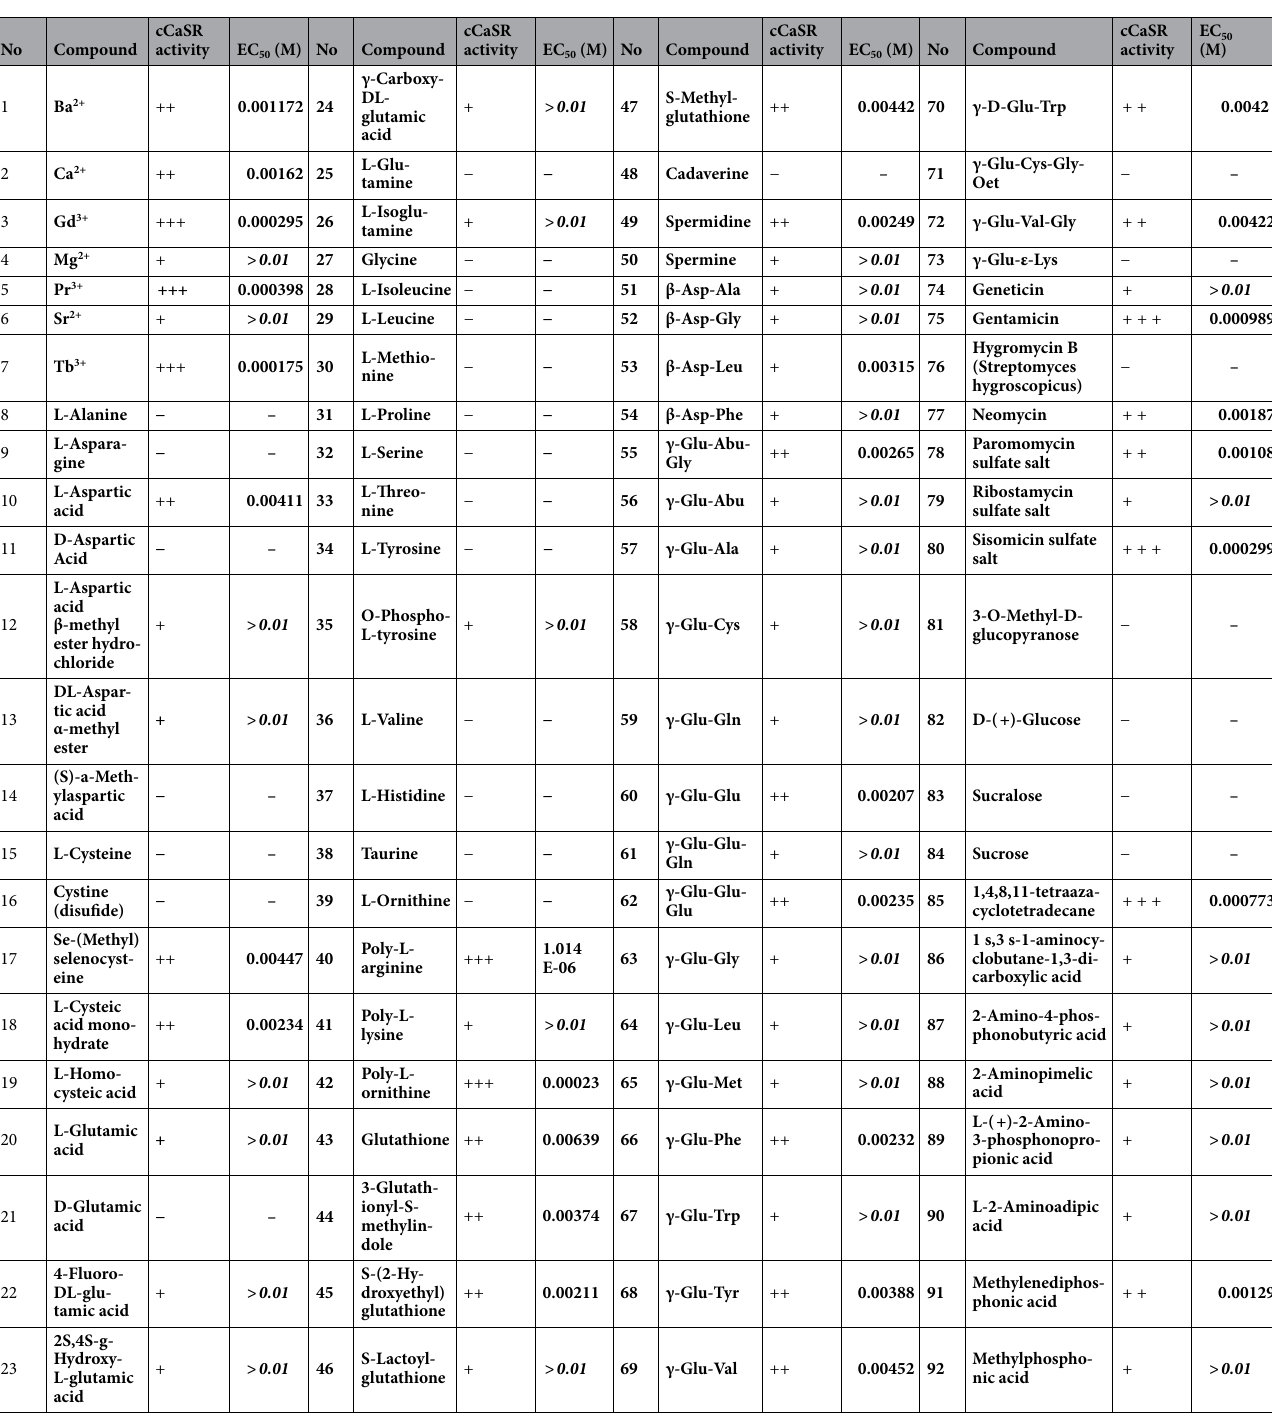
Table 1. Activity measurement of 92 agonists on the cCaSR: All compounds listed here were screened using the HEK T-Rex/ natClytin cell line inducibly expressing cCaSR in an agonist assay. All measurements were repeated over at least three wells on the same assay plate. If the maximal response to a compound was not reached, the EC 50 value could not be determined and is expressed as an estimation at > 0.01 M. For all agonists, the activity on cCaSR is described in a separate column: + : EC50 equal or above to 0.1 M, ++: EC50 below 0.1, +++: EC50 below 0.001. The compounds are grouped by different classes. 1–7: Cations, 8–39: Amino acids and derivatives, 40–42: Polybasic peptides, 43–47: GSH and derivatives, 48–50: Biogenic amines, 51–54: β-aspartyl peptides, 55–73: γ-glutamyl peptides, 74–80: Aminoglycoside antibiotics, 81–84: Sugars and derivatives, 85: 1,4,8,11-tetraazacyclotetradecane, 86–92: Organic